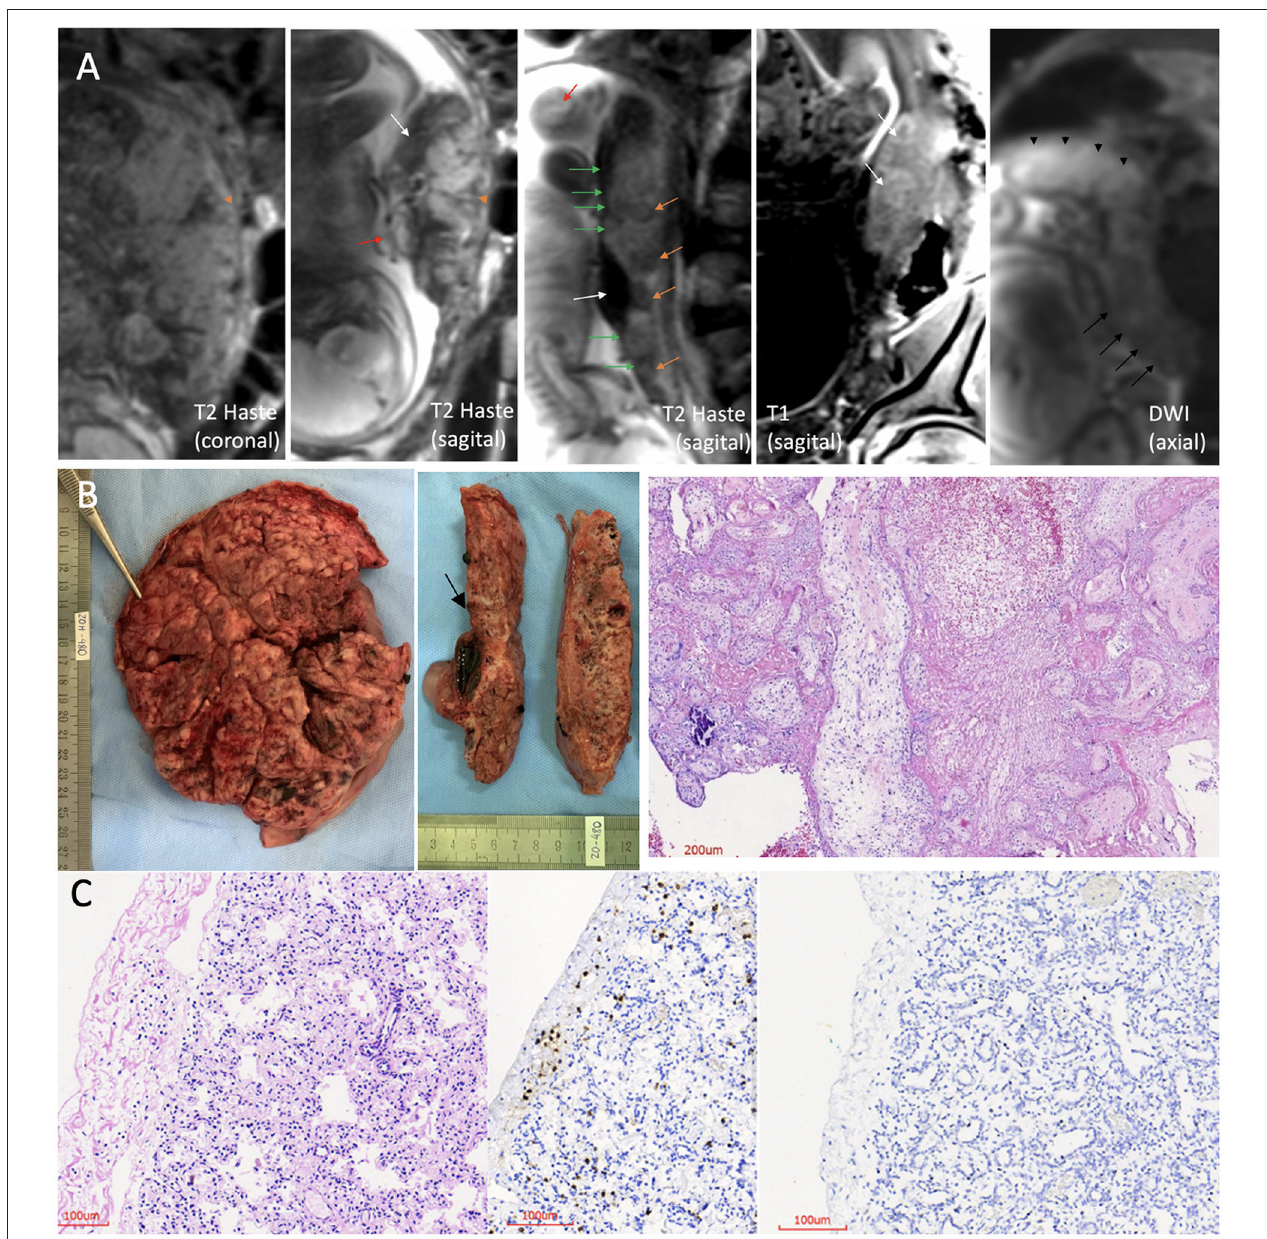
FIGURE 1 | Fetal–placental magnetic resonance imaging (MRI); pathology of the placenta and lung histopathology. (A) 3.0 Tesla MRI of placenta and fetus, using two 18-channel abdominal coil, showing the umbilical cord with no evident flow, no evident signal void (red arrow), and heterogeneous placenta, with ill-defined cotyledons, with contours having fewer lobulations than usual and wedge-shape or round-shape hypointense signal areas in T2 Haste sequence (orange arrowhead and orange arrows, respectively). The placental image showed insertion in the posterior wall, with a “cake” aspect, and the uterine insertion base is smaller than usual, which gave it a “shrinkage” aspect (coronal and sagittal T2 Haste images). Altered habitual T1 and T2 placental signals with hyposignal plate in T2 along its entire length of the fetal face, appearance of a line drawn in pencil (green arrows), presence of large and dilated vessels with massive thrombosis characterized by the unusual hyperintense signal in T2, and also blood lakes between the placental tissue (areas of hypointense signal in T2 and hyperintense signal in T1, predominating in the periphery) (white arrows). Diffusion-weighted image (DWI) sequence shows higher restriction than the usual pattern, and this is more evident in the right posterolateral portion of the placenta (black arrowheads), where vascular dilation and thrombosis are more pronounced. There are also areas of necrosis characterized by the facilitation mechanism more evident in the left placental portion (black arrows). (B) Placenta pathology. Left: maternal surface is wrinkled, compact, and yellow-tan with patchy hemorrhages. Middle: cut surfaces with extensive and diffuse fibrin deposition and recent infarcts. At the level of the umbilical cord insertion, there is a large subchorionic thrombus (arrow). Right: histological section with villitis, intervillositis, and massive fibrin deposition with intervillous thrombosis. (C) Histological sections of the lung. Left: thick alveolar septa with aggregates and scattered lymphocytes in pleura (hematoxylin and eosin). Middle: immunohistochemistry showing CD3 + T lymphocytes in the pleura and alveolar septa. Right: immunohistochemistry showing no lymphocytes in a normal control lung (patient without COVID-19).